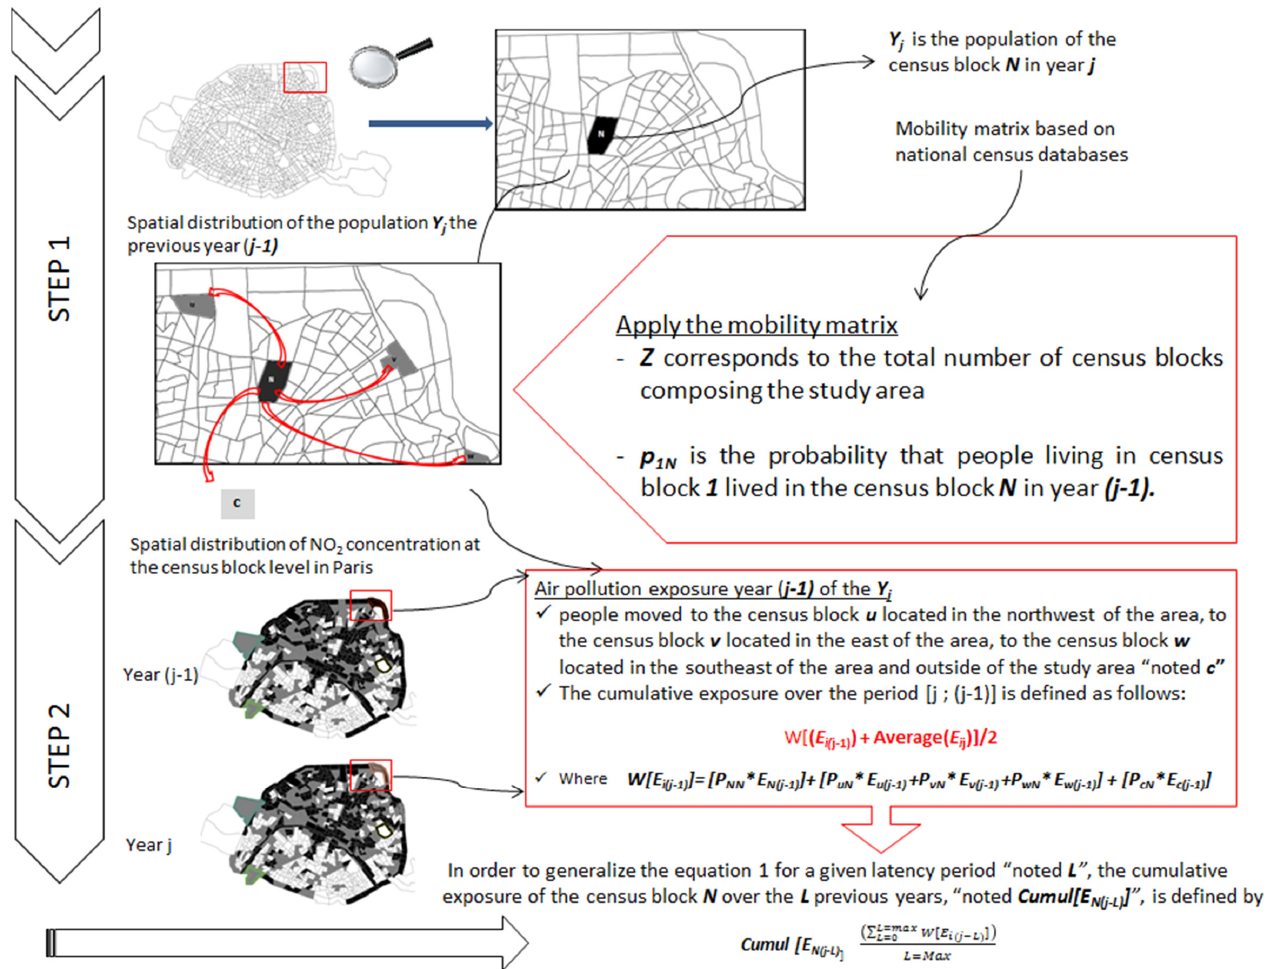
Figure 1. Assessment of cumulative exposure accounting for residential mobility.